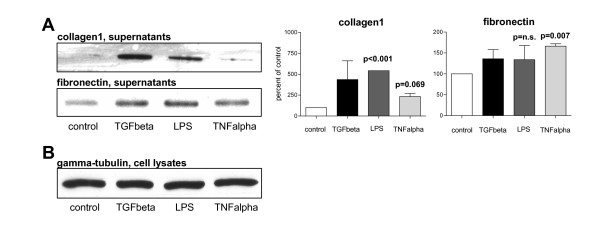
Immunoblot of PSC cell culture supernatants and cell lysates. Cell culture supernatants and cell lysates of vehicle-, TGFbeta-, LPS- and TNFalpha-treated PSC were subjected to SDS-PAGE followed by incubation with (A; supernatants) anti-collagen1 and anti-fibronectin antibodies or (B; cell lysates) an anti-gamma-tubulin antibody Densitometry is shown in percent of vehicle-treated control PSC supernatants; n.s. = statistically not significant.